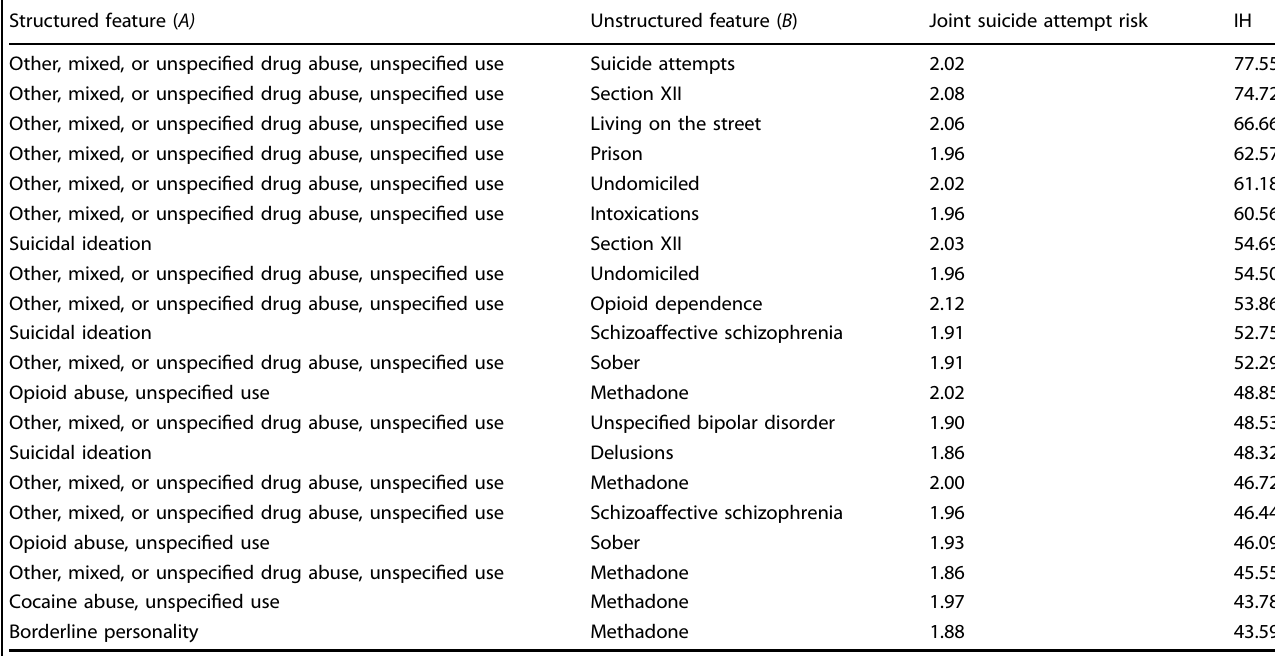
Table 8. Structured-unstructured feature pairs A - B with high interaction heterogeneity (IH) values. Structured feature (